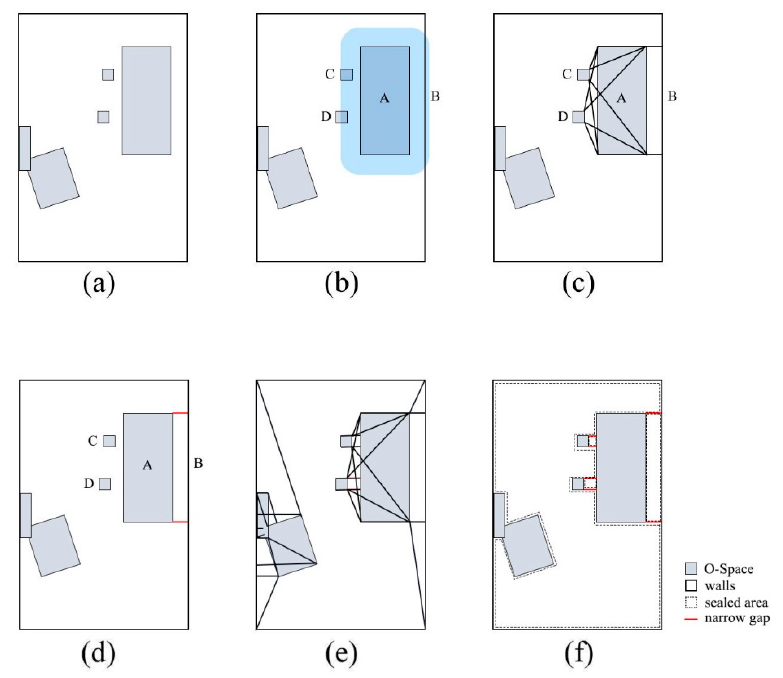
Figure 7. The generation of narrow gaps. ( a ) The projection of Room A. ( b ) The buffer of the 𝐼𝑂 A. ( c ) The minimum distances (MDs) between the endpoints of A and B, C, and D. ( d ) The narrow gaps of 𝐼𝑂 A. ( e) All MDs between the endpoints of each 𝐼𝑂 and the 𝐼𝑂s in its buffer. ( f ) The narrow gaps of Room A.